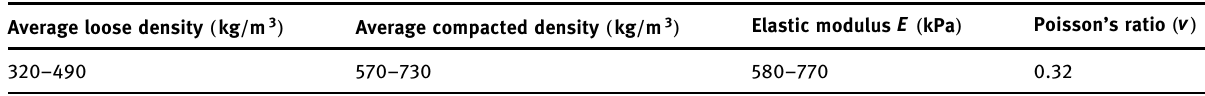
Table 7: Properties of tire chips used in the study Average loose density ( kg m 3